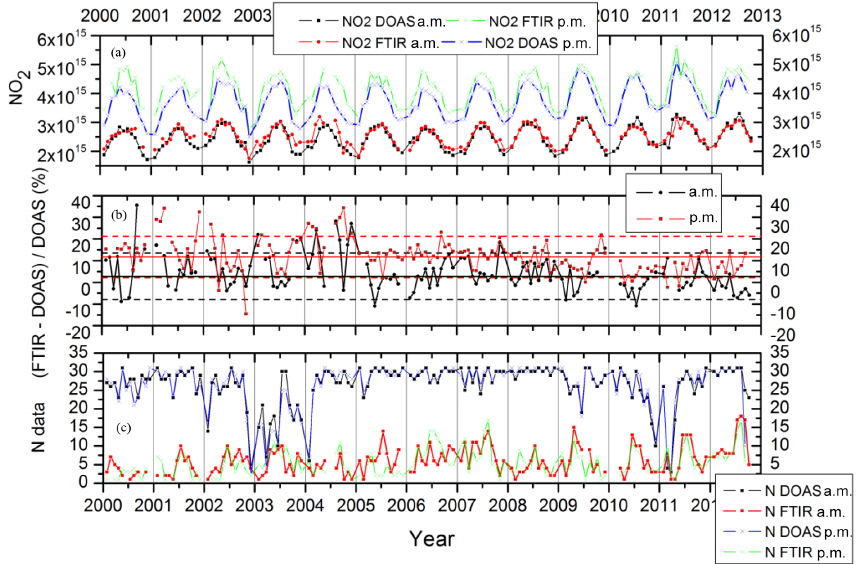
Figure 5. (a) Monthly mean evolution of NO 2 VCD from DOAS (black dots for a.m. and blue for p.m.) and FTIR (red dots for a.m. and green for p.m.). (b) Relative differences: solid line presents the mean relative difference and the dash lines represent the mean relative difference plus and minus the standard deviation in black for a.m. and in red for p.m. values. (c) Shows the number of days used to compute the monthly